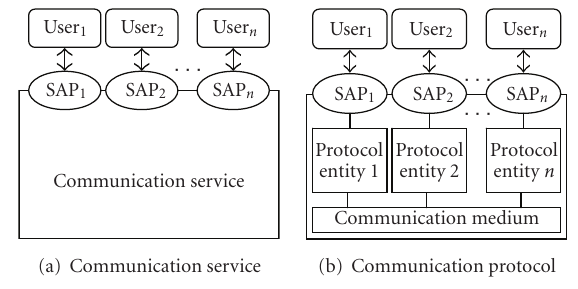
Figure 1: A communication system at two levels of